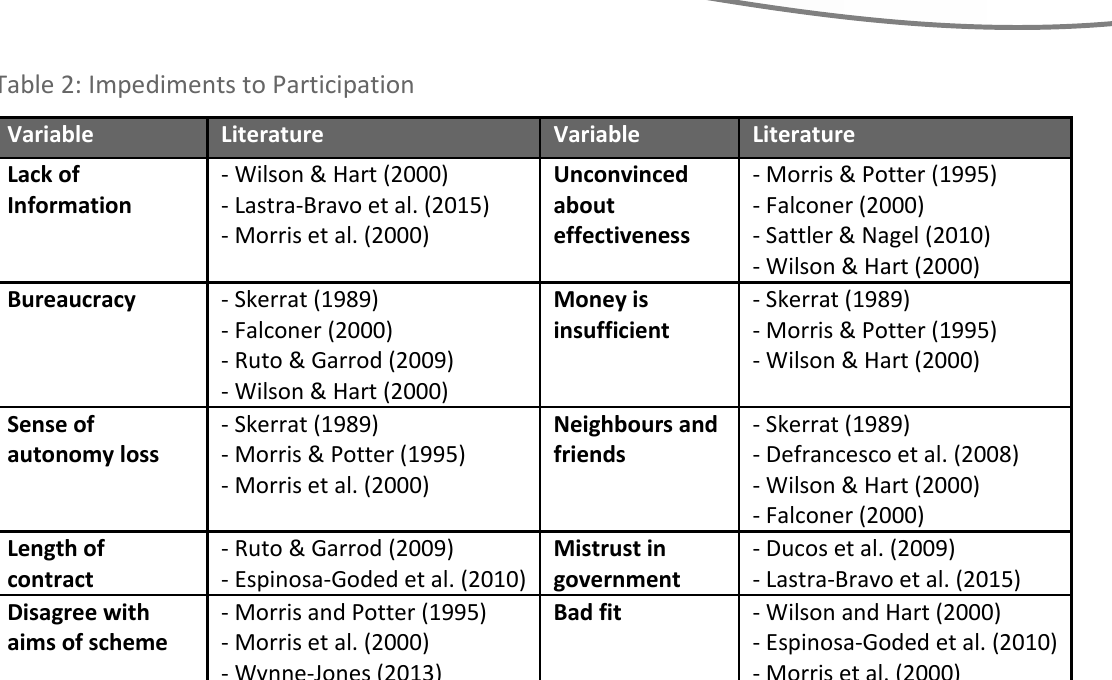
Table 2: Impediments to Participation Variable Literature Variable Literature Lack of Information